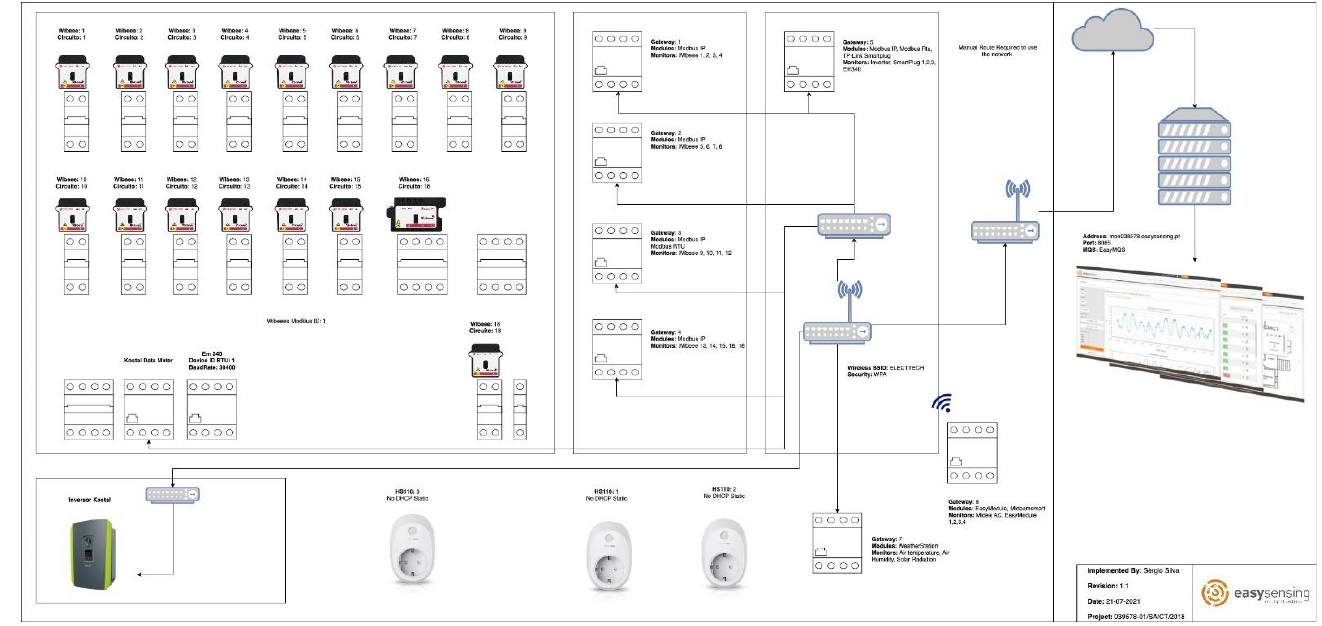
Figure 2. Schematic diagram of the acquisition system.